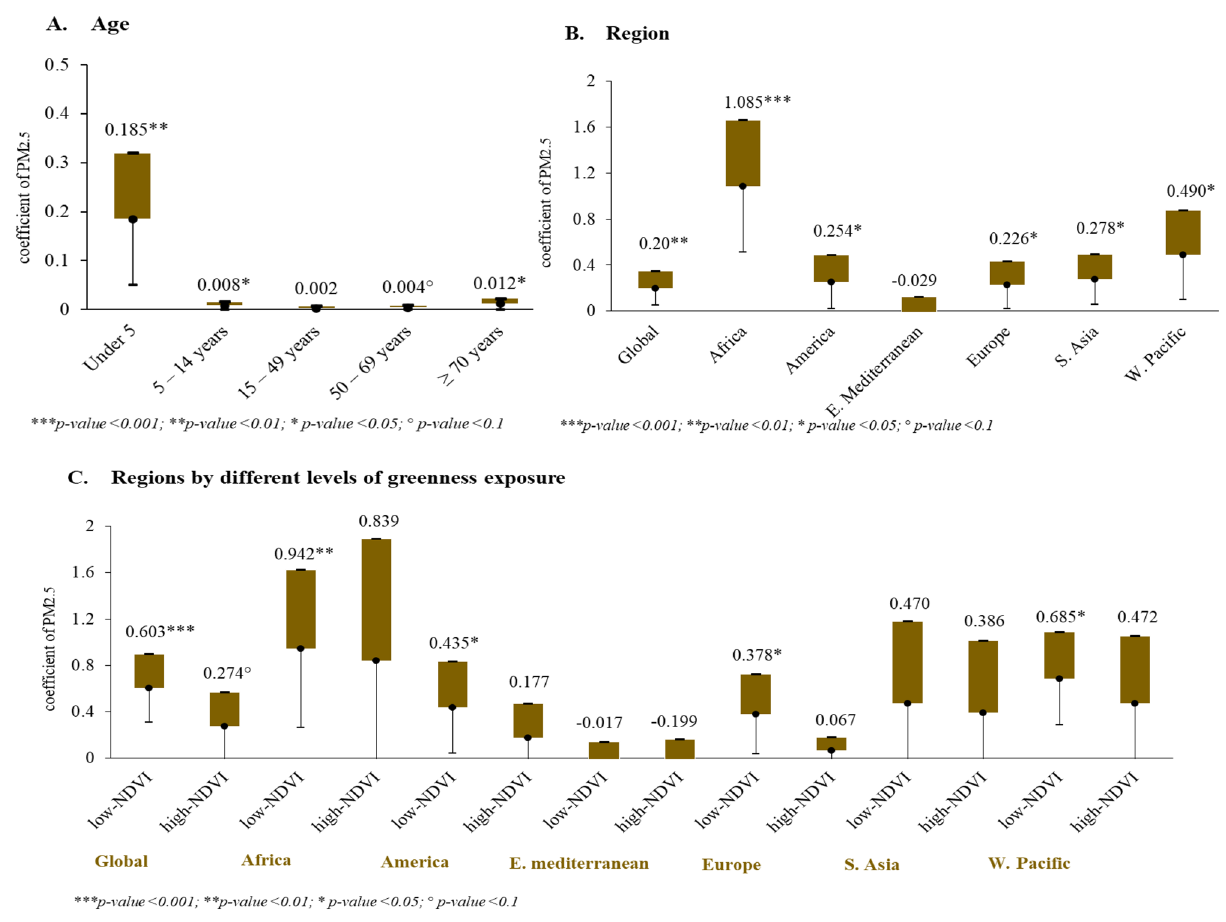
Figure 2. Subgroup analysis, stratified by ( A ) age, ( B ) WHO region; and ( C ) WHO Regions by different levels of